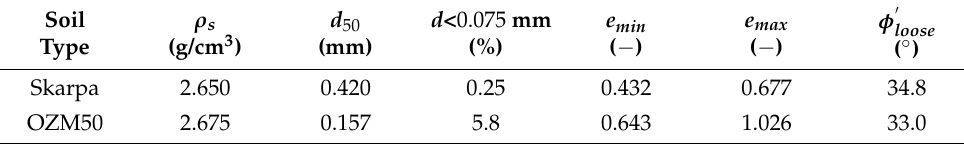
Table 1. Basic physical characteristics and mechanical properties of the soils tested.